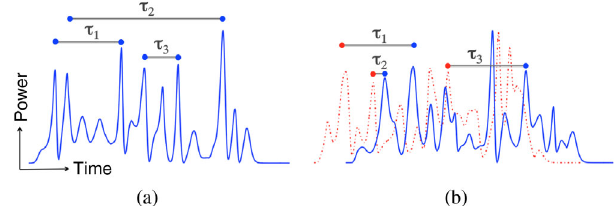
FIG. 1. (a) The simplest realization with a single SASE pulse: Photons separated by different delays (e.g., τ 1 , τ 2 , and τ 3 ) effectively drive independent pump-probe experiments within the same pulse. (b) More complicated setups are also possible, for example, pumping with one wavelength (red dashed line) and probing with another (blue solid line). In both cases, the temporal resolution of the reconstruction is determined by the spike width or measurement resolution and not the pulse duration as in a traditional pump-probe